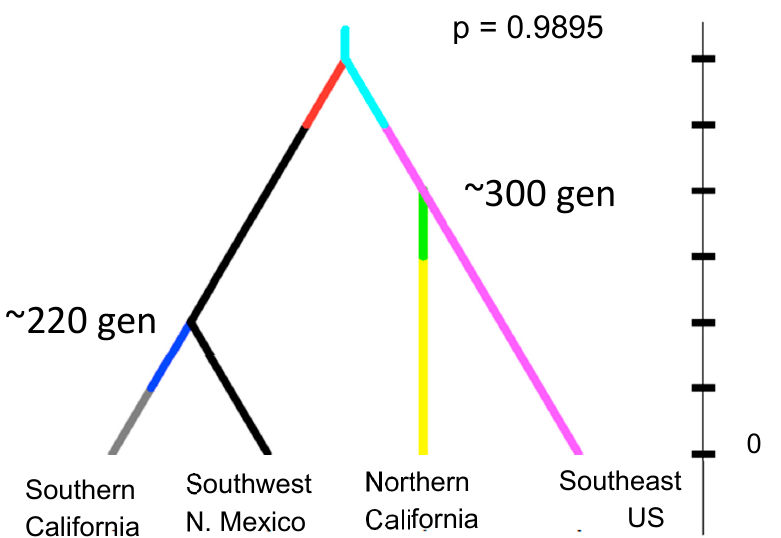
Figure 6. Estimates of the time of splits (in generations) of populations of Aedes aegypti in major regions of western North America based on microsatellites. The topology of the tree is supported over alternative topologies by the Bayesian posterior probability shown (methods in [51]). From [50]. Similar to California where previously undetected populations are reported as new introductions is the case of the Black Sea. Beginning in the early 2000s, Ae. aegypti was reported as new introductions after an apparent absence of about 50 years (e.g., [52]). Genetic analyses of these “new” introductions showed them to be older than all other Asian populations dating to about 200 years [48].